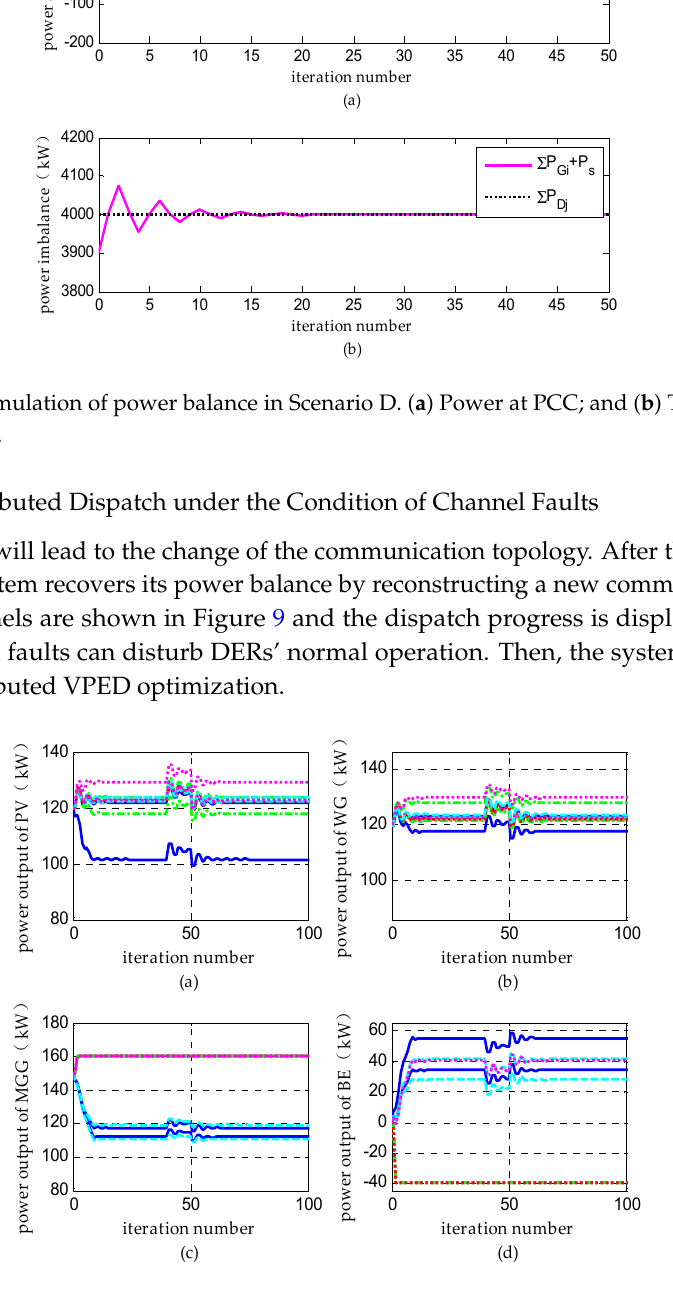
Figure 10. Dispatch results in Scenario D . ( a ) Power output of PV; ( b ) Power output of WG; ( c ) Power output of MGG; and ( d ) Power output of BE.